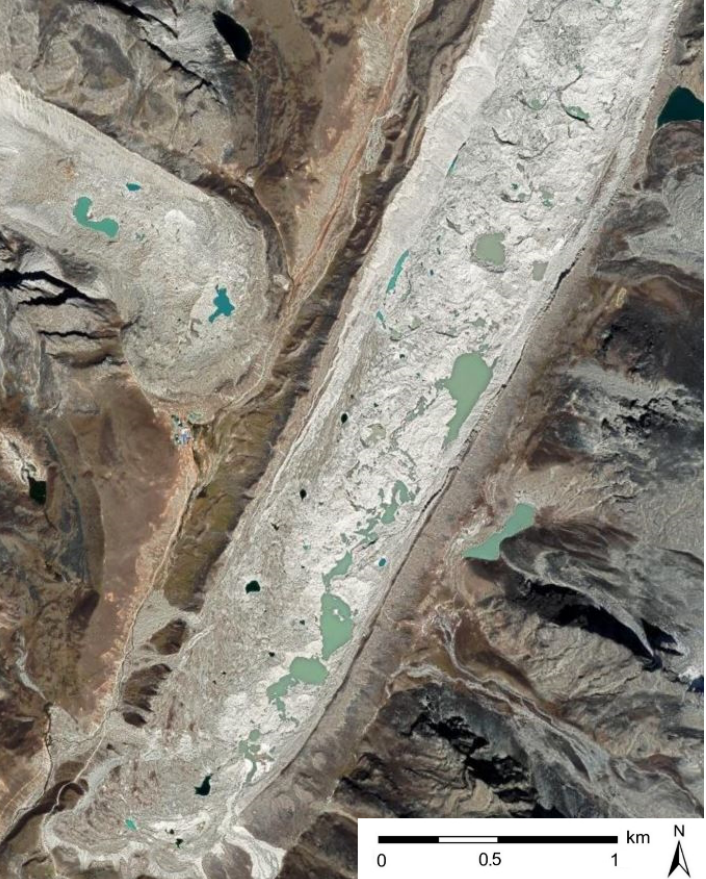
Figure 5. Supraglacial water bodies on the ablation zone of the Khumbu Glacier in central Himalaya. Imagery source: Google Earth. Imagery date: 9 October